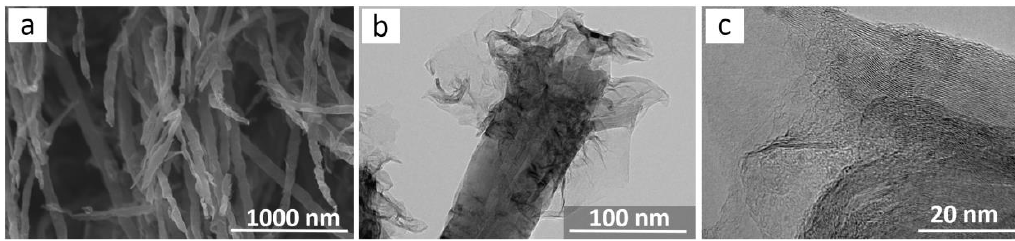
Figure 3. SEM ( a ) and TEM ( b , c ) images of CNTs after the array was treated with hydrogen plasma.